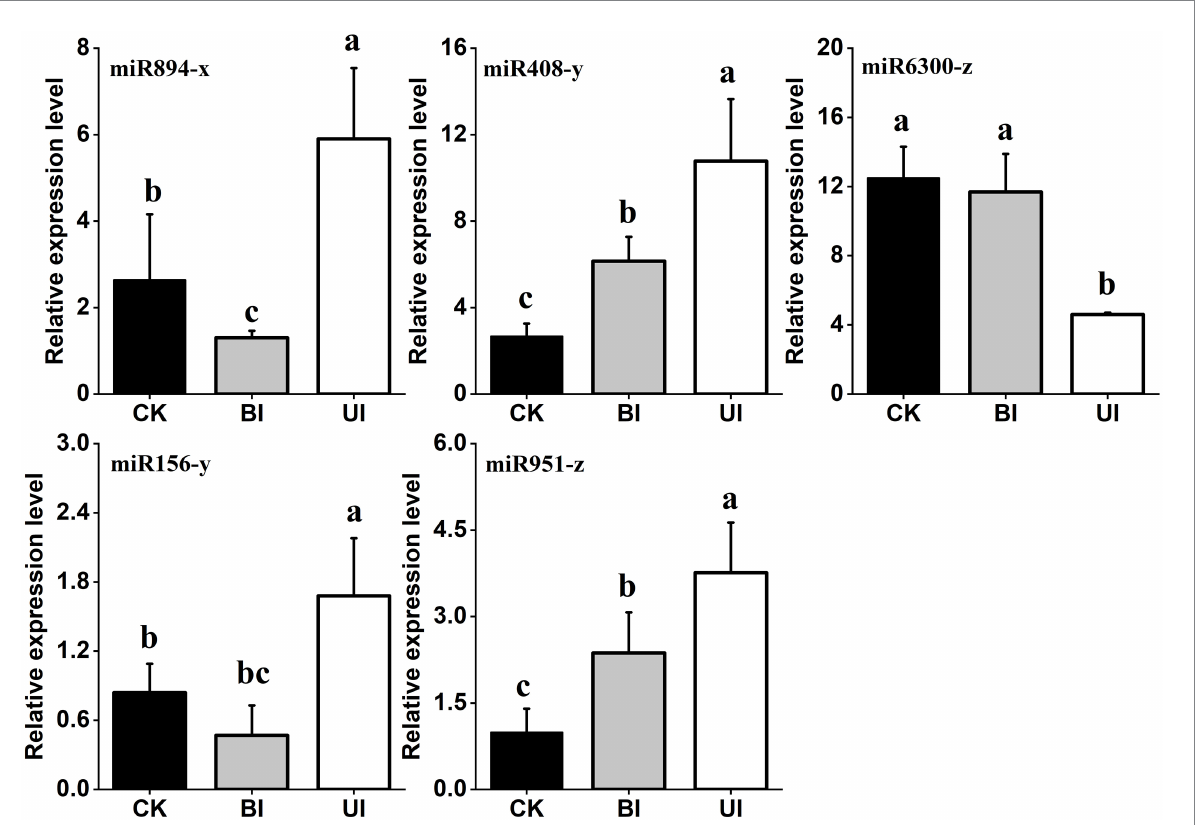
FIGURE 9 Quantitative reverse transcription polymerase chain reaction (qRT-PCR) validation of the expression profiles of five miRNAs. The expression levels of miRNAs were normalized to the level of U6 snRNA. Fold changes in the expression levels of miRNAs were estimated by the 2 – △△ CT method relative to the levels in the roots. Data are reported as the mean ± standard error (SE) for three independent experiments. CK (control check, without inoculation), BI (presymbiotic phase, 3 weeks after inoculation), and UI (symbiotic phase, 5 weeks after